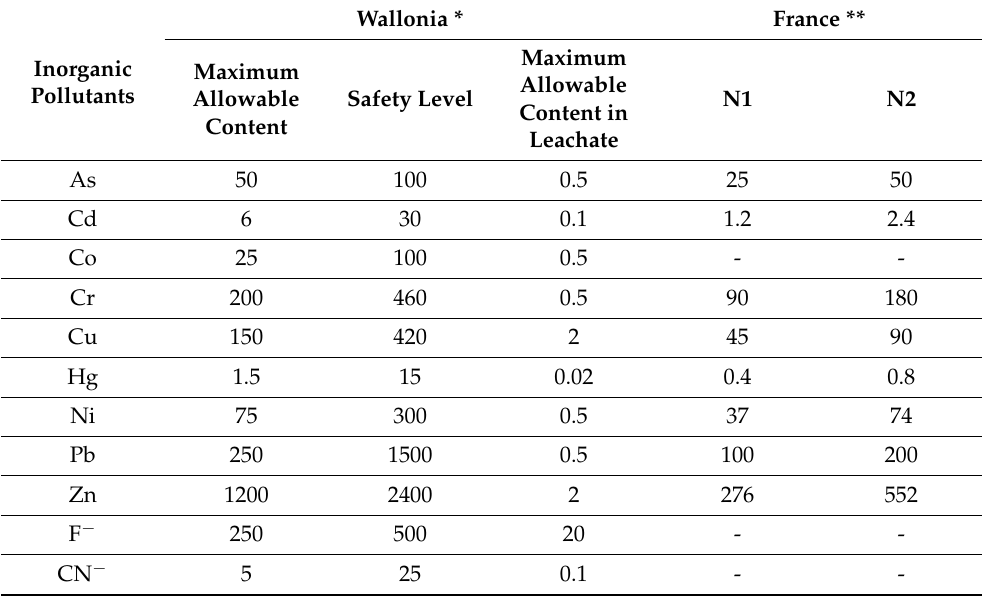
Table 2. Comparison between Walloon and French legislations about inorganic pollutant levels (mg/kg dry matter ) allowed in dredging